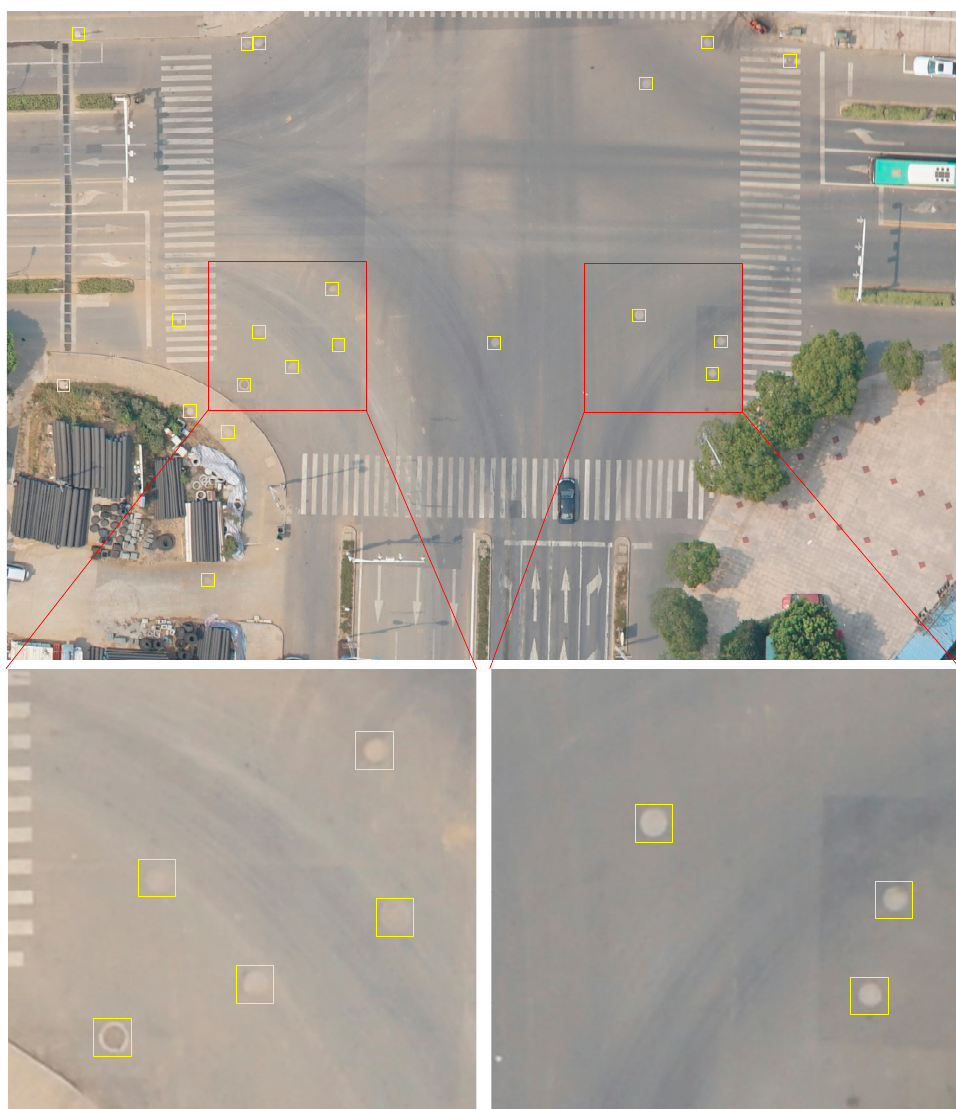
Figure 4. Ground truth boxes.